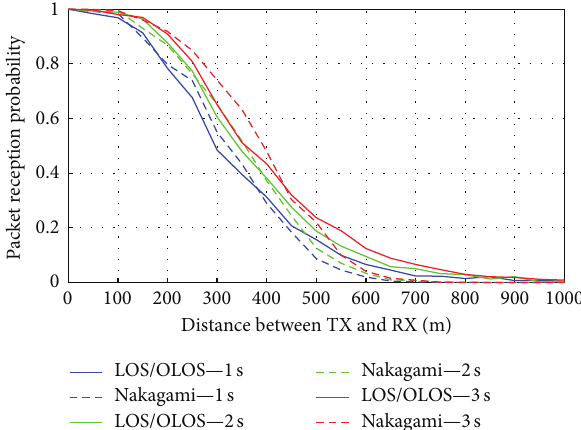
Figure 10: Packet reception probability for the two different channel models and for three different vehicle